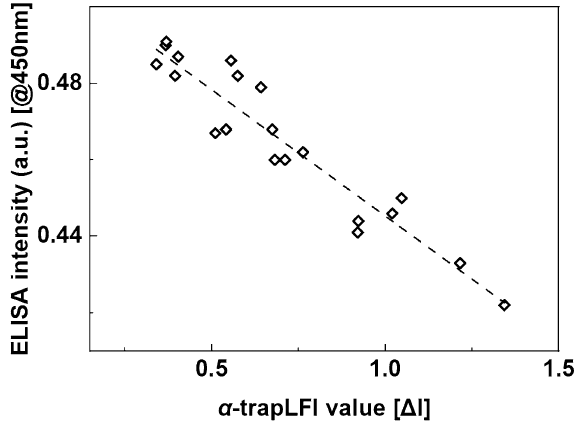
Figure 7. Human salivary cortisol level measured using conventional ELISA and α -trapLFI sensor. All images were obtained using a ChemiDoc XPS + imaging system (Bio-Rad), and the band intensities were measured using Image Lab software (version 6.1, https:// www. bio- rad. com/ en- uk/ produ ct/ image- lab- softw are? source_ wt= image labso ftware_ surl& ID= KRE6P